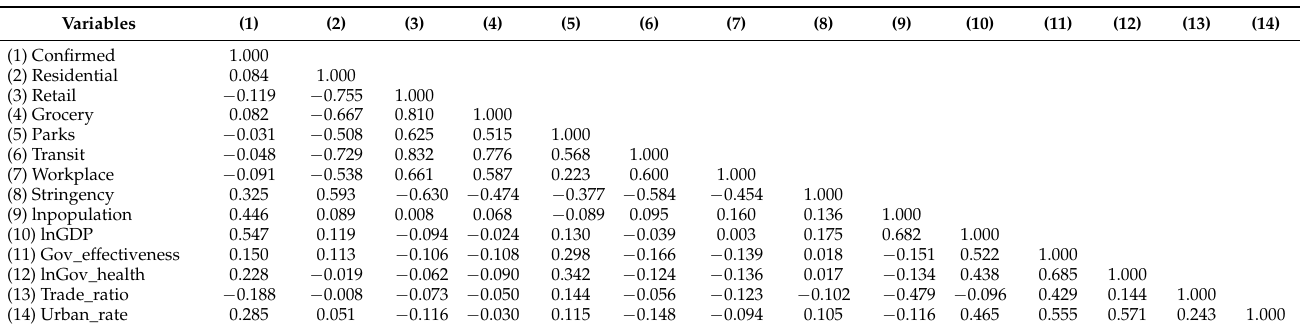
Table A1. Matrix of